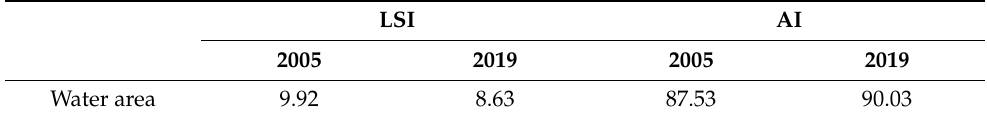
Table 2. Class level index in 2005 and